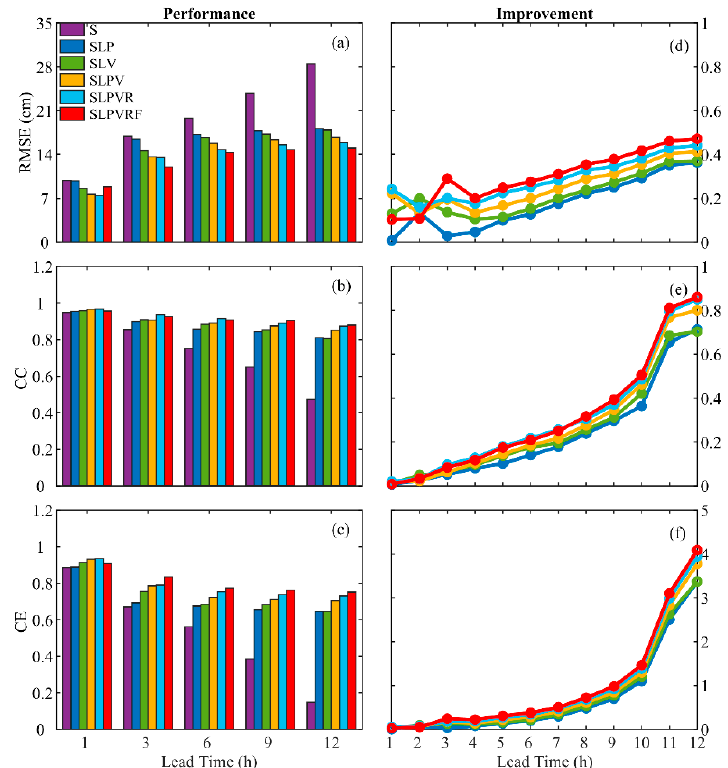
Figure 12. Prediction capability and performance improvement in terms of ( a , d ) RMSE ; ( b , e ) CC ; and ( c , f ) CE for all the validation events.